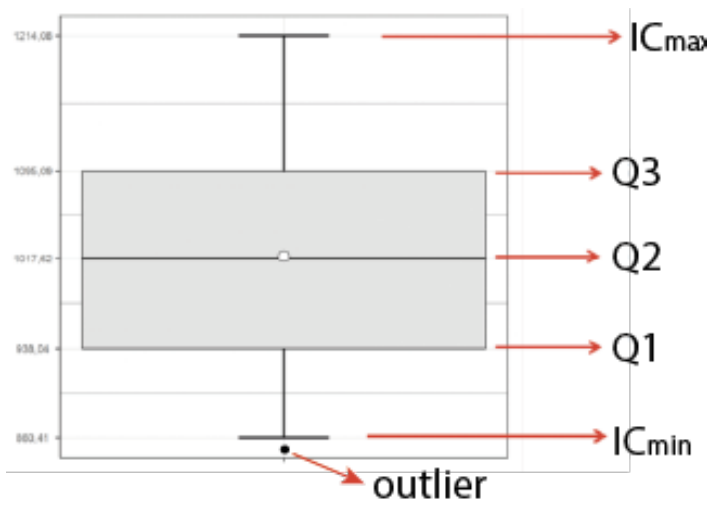
Figure 26. Boxplot chart.